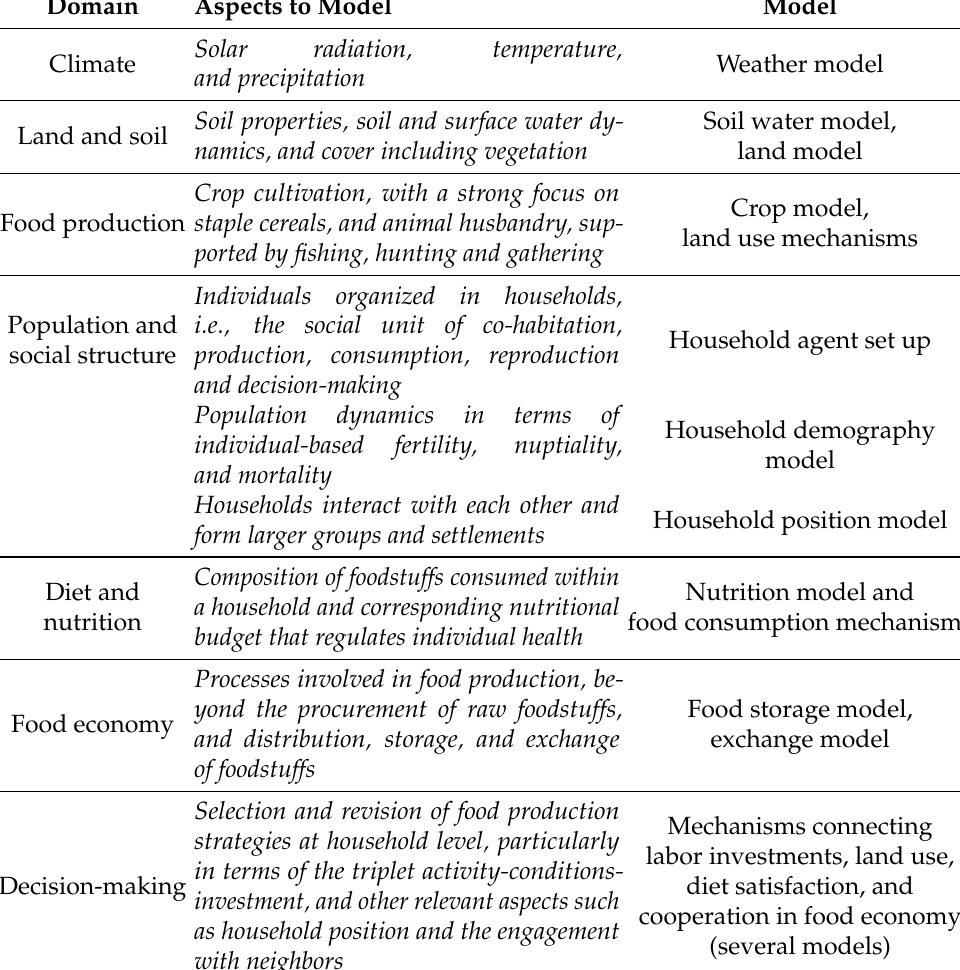
Table 1. Correspondence between domains and the submodels planned for the Indus Village